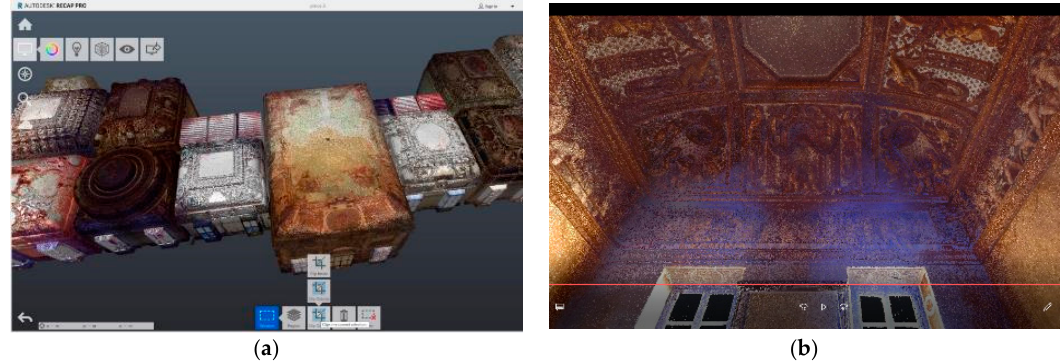
Figure 22. ( a ) A screenshot of the LiDAR points model managed in the Recap environment; ( b ) A screenshot from the video navigation achieved from LiDAR points cloud. ( b ) A screenshot from the video navigation achieved from LiDAR points